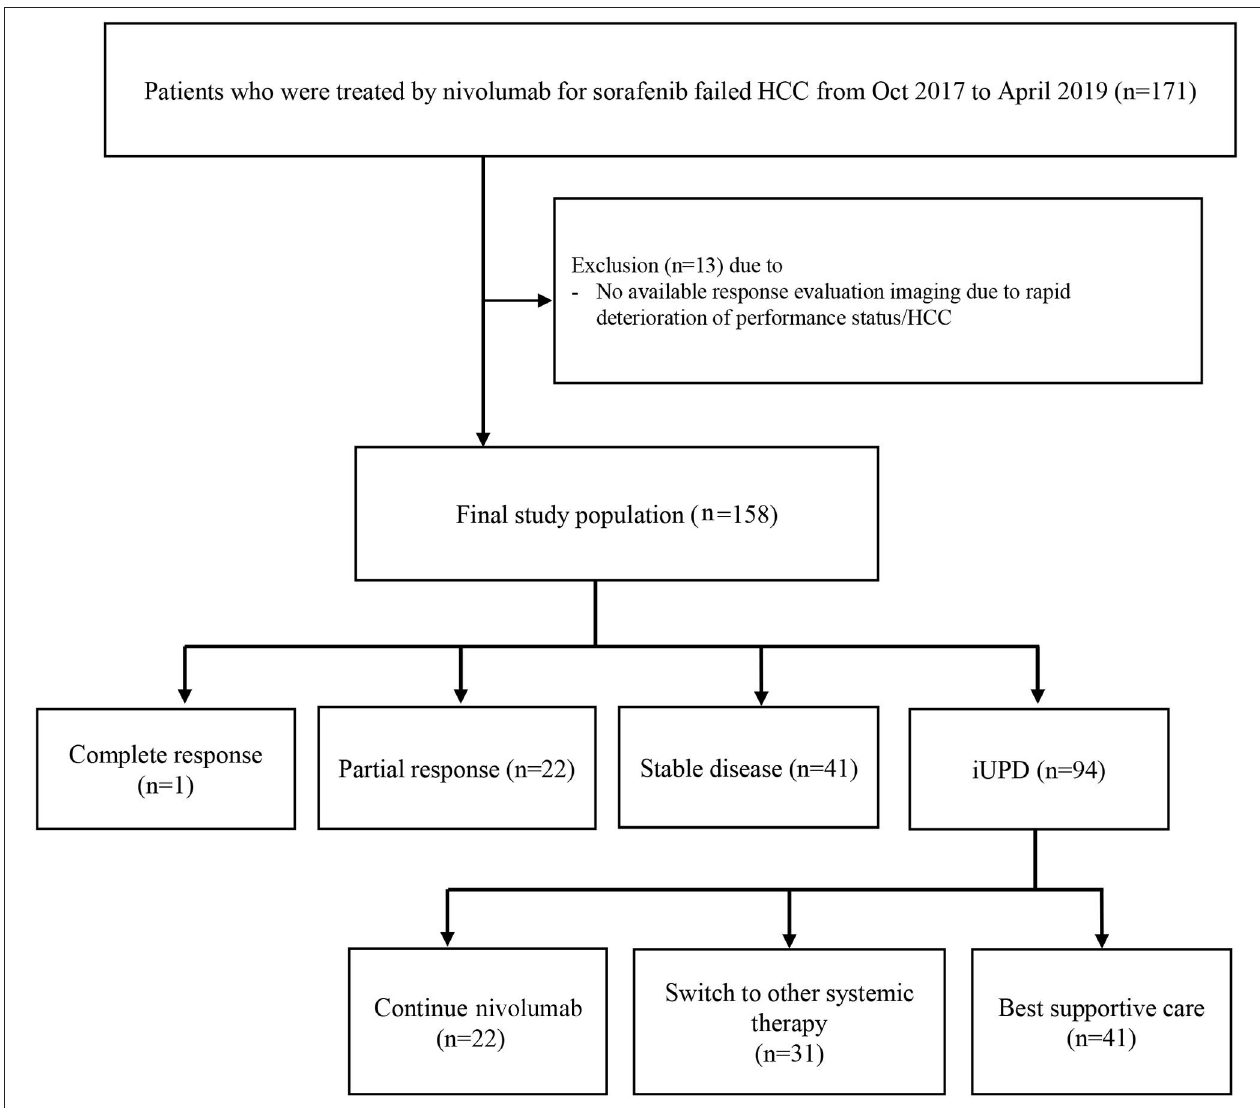
FIGURE 1 | Patient enrollment process. iUPD, immune unconfirmed progressive